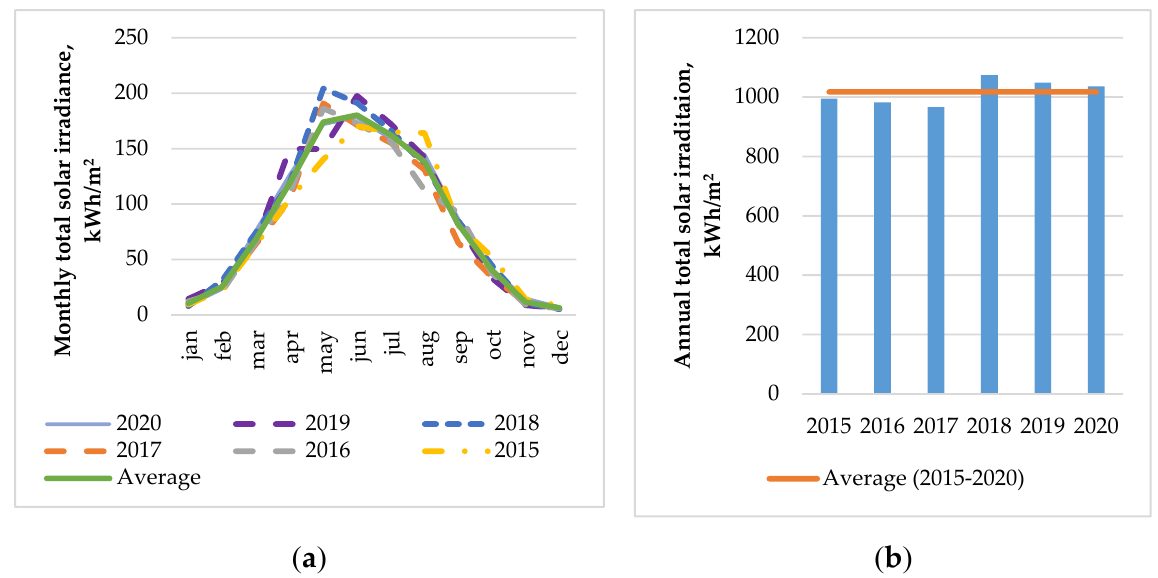
Figure 3. Comparison of monthly total solar radiation ( a ) and annual total solar radiation ( b ) in Riga from 2015 to 2020 [22].